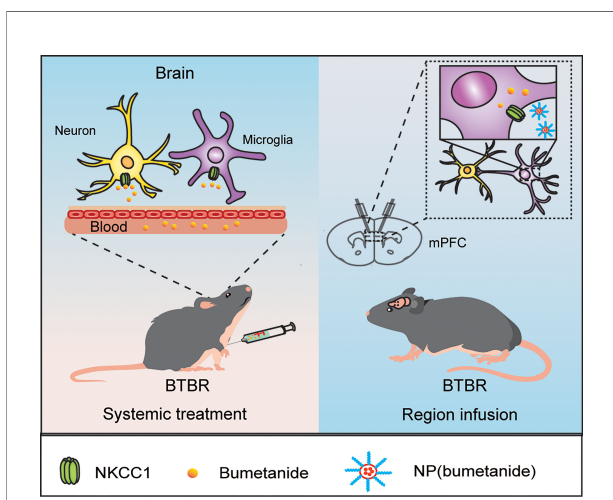
FIGURE 6 | A proposed work model by bumetanide and NP(bumetanide) in the BTBR